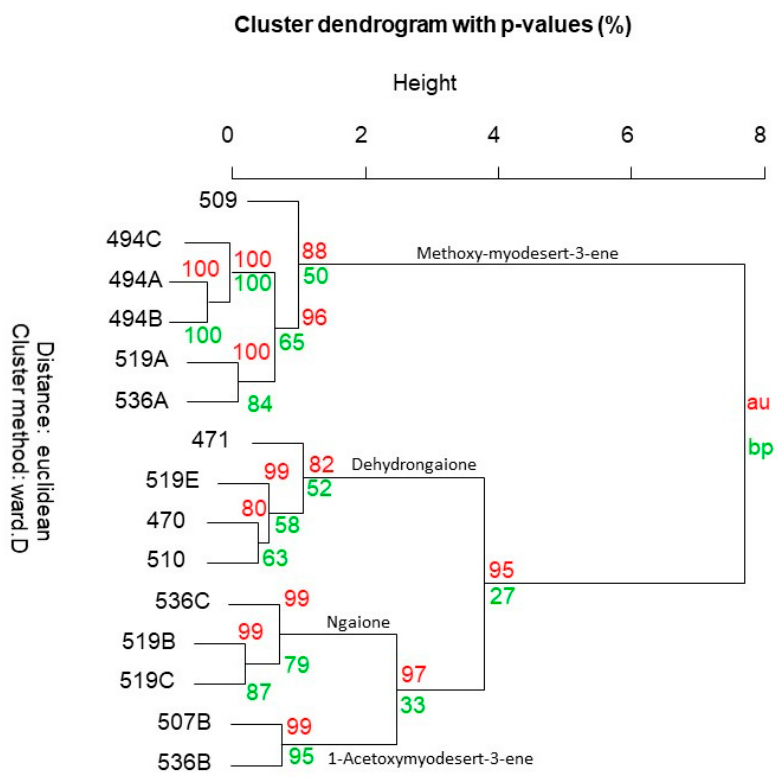
Figure 2. Dendrogram essential oil components from Eremophila deserti .